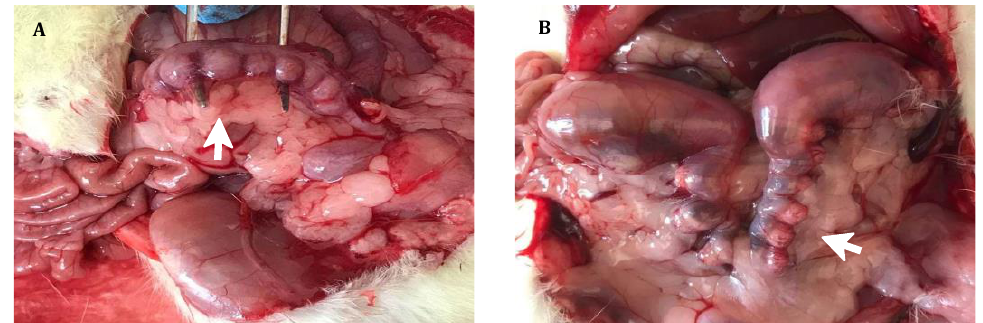
Figure 1 . Photographs of the uterus of resorbed fetus (arrow) in methotrexate-treated group ( A ) and carvedilol- methotrexate combination group ( B )